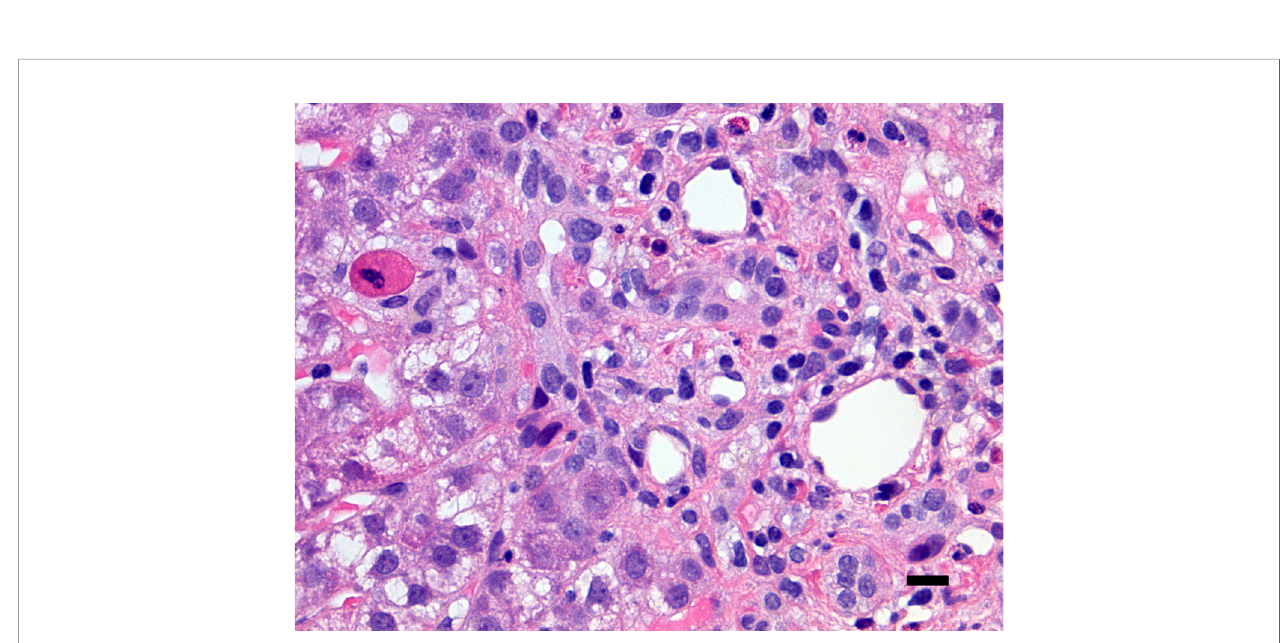
FIGURE 4 | Close-up of a portal tract of the liver of the same patient presented in Figure 3 including neutrophils and eosinophils with an apoptotic hepatocyte close to the portal tract (left corner of the microphotograph). There is no ductular proliferation, some emperipolesis of in fl ammatory cells into the bile duct epithelium is noted (right side of the microphotograph) (hematoxylin-eosin staining, ×400 original magni fi cation, bar: 25